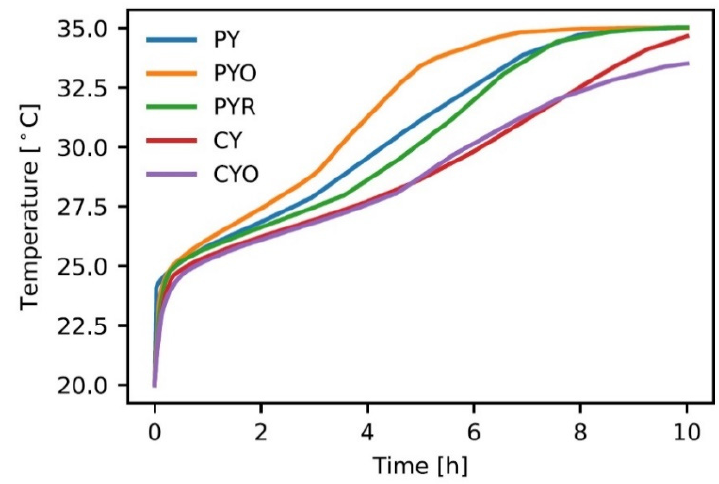
Figure 11. PCM panel designs: PYO—pyramids with offset, CY—cylinders (adapted, copyright 2022 Kamidollayev et al. (http://creativecommons.org/licenses/by/4.0/), accessed on 26 September 2022) [35].